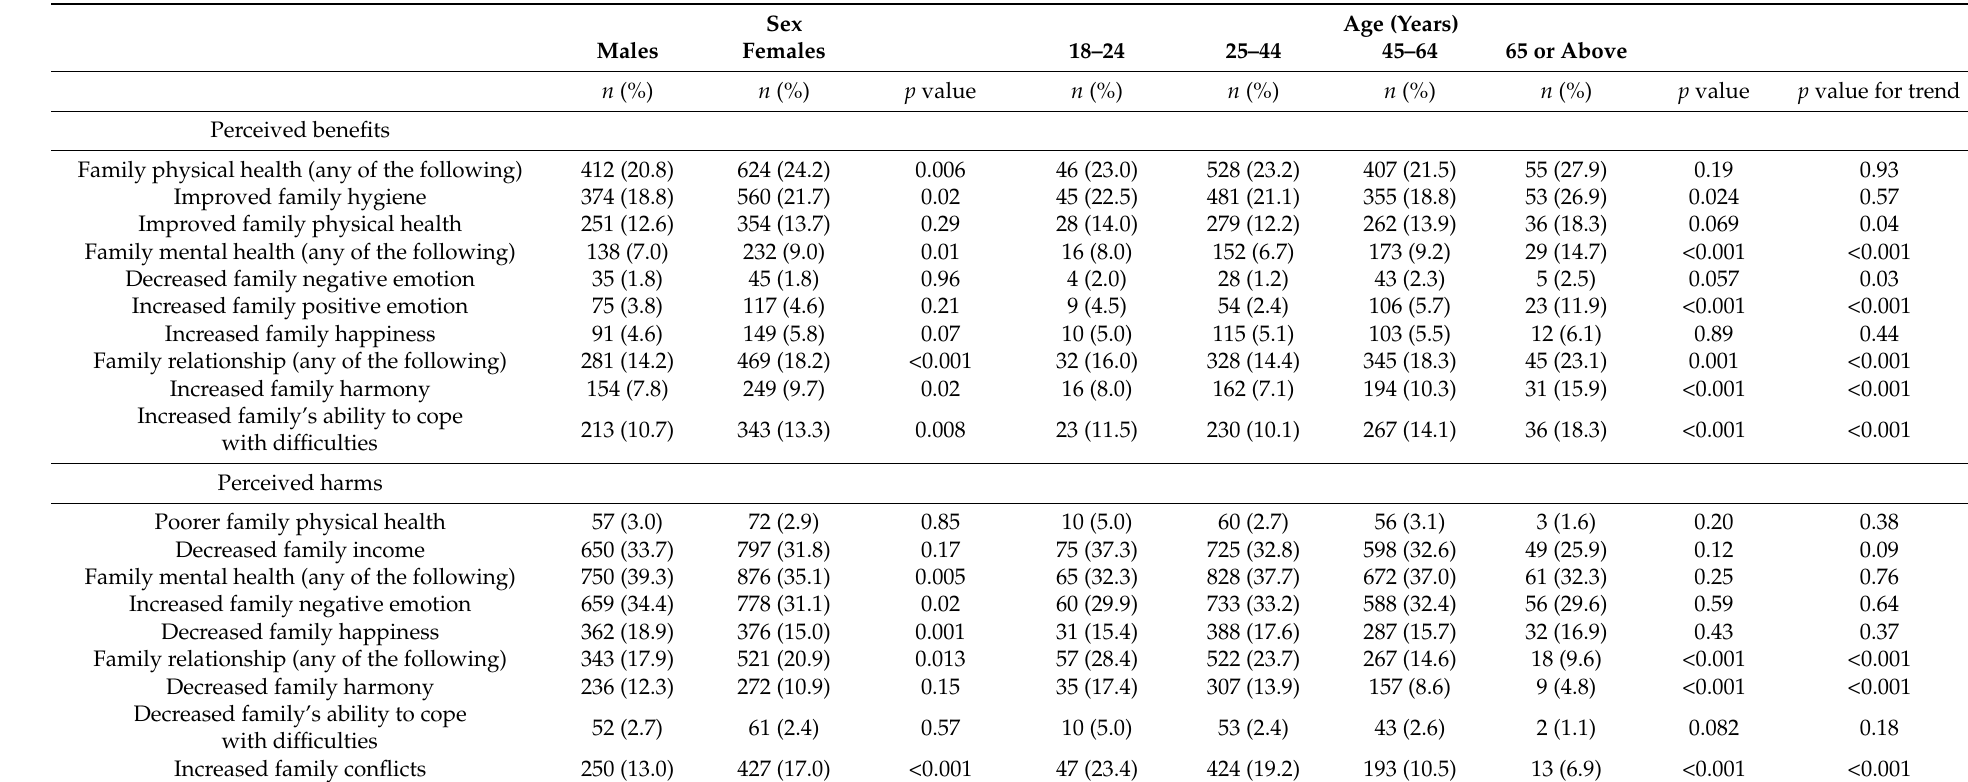
Table 2. Perceived benefits and harms of COVID-19 by sex and